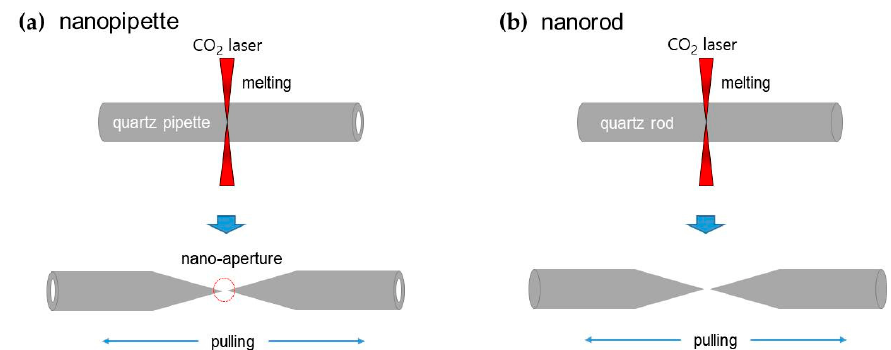
Figure 1. Fabrication of nanopipette ( a ) and nanorod ( b ) by using a mechanical puller (P-2000, Sutter Instruments). After the CO 2 laser focused on the middle of the quartz pipette (1 mm outer diameter, 0.5–0.7 mm inner diameter) or quartz rod (1 mm diameter) for melting, the machine fabricated two identical pencil-shaped nanopipettes and nanorods by pulling and breaking off the quartz pipette and quartz rod.